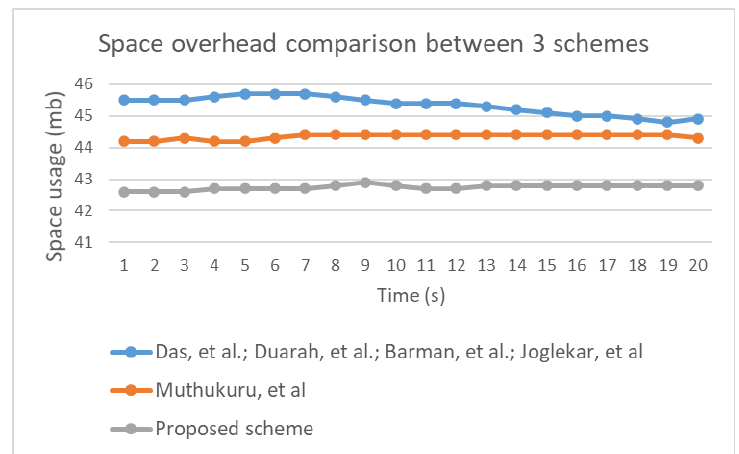
Figure 35. Comparison of space usage between the proposed scheme and other schemes.